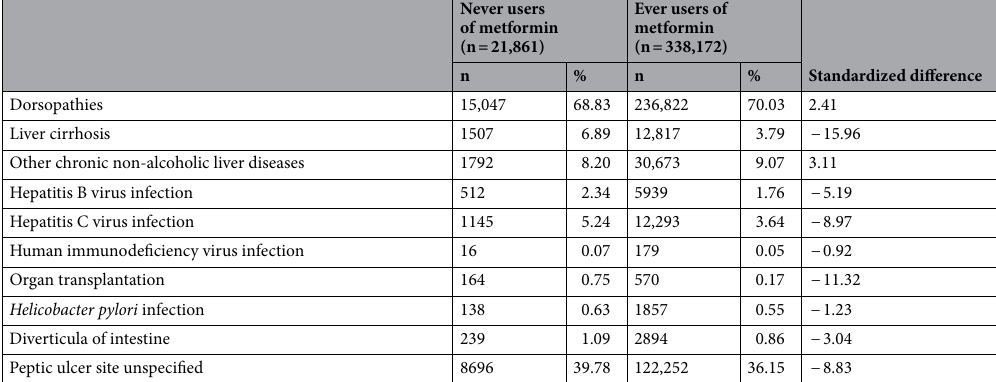
Table 1. Characteristics in never users of metformin and ever users of metformin. *Age is shown as “mean ± standard deviation”. The classification of occupation can be seen in “Materials and